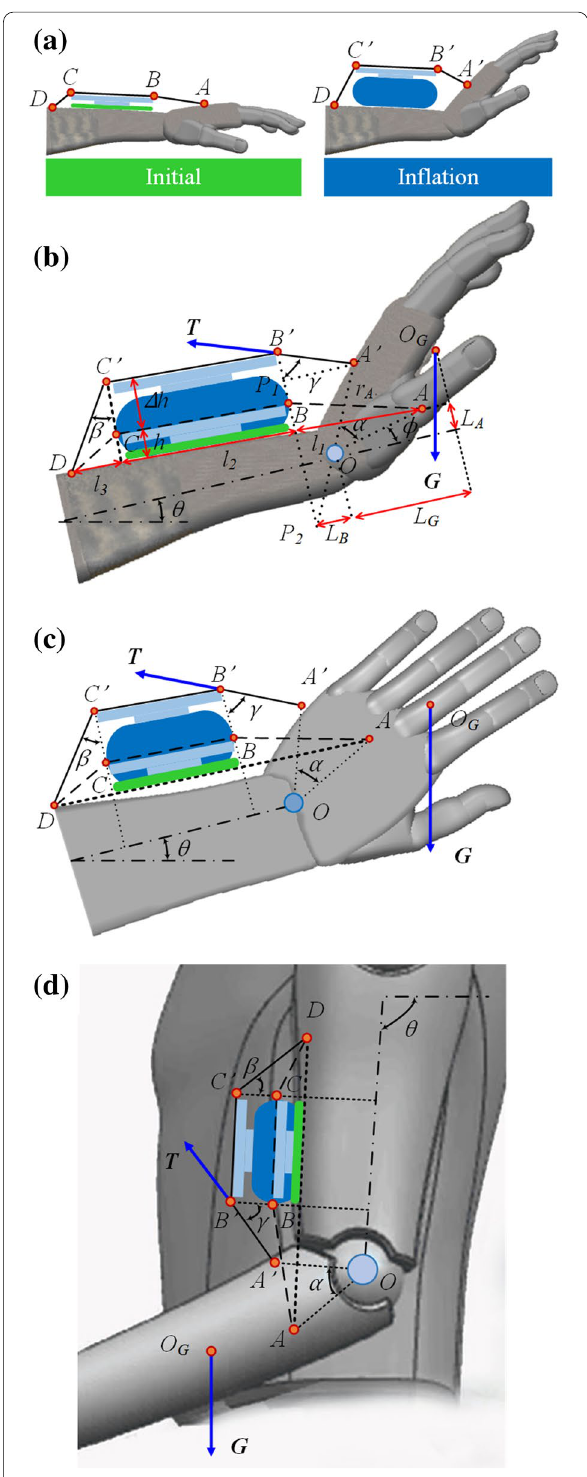
Figure 4 Analysis of rehabilitation motion: ( a ) Wrist posture changes under the action of the RSPA, ( b ) Illustration of wrist extension, ( c ) Illustration of wrist ulnar deviation, ( d ) Illustration of elbow